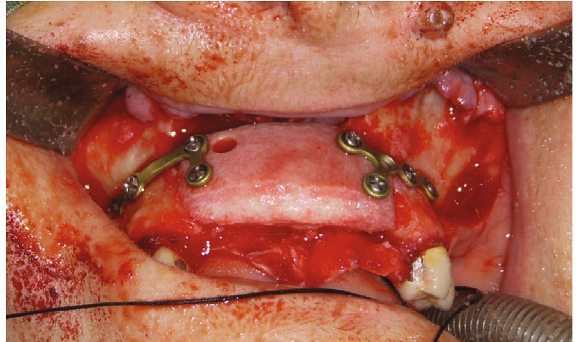
Figure 6: Equine xenograft has been fi xed by one titanium plate and four screws per side.